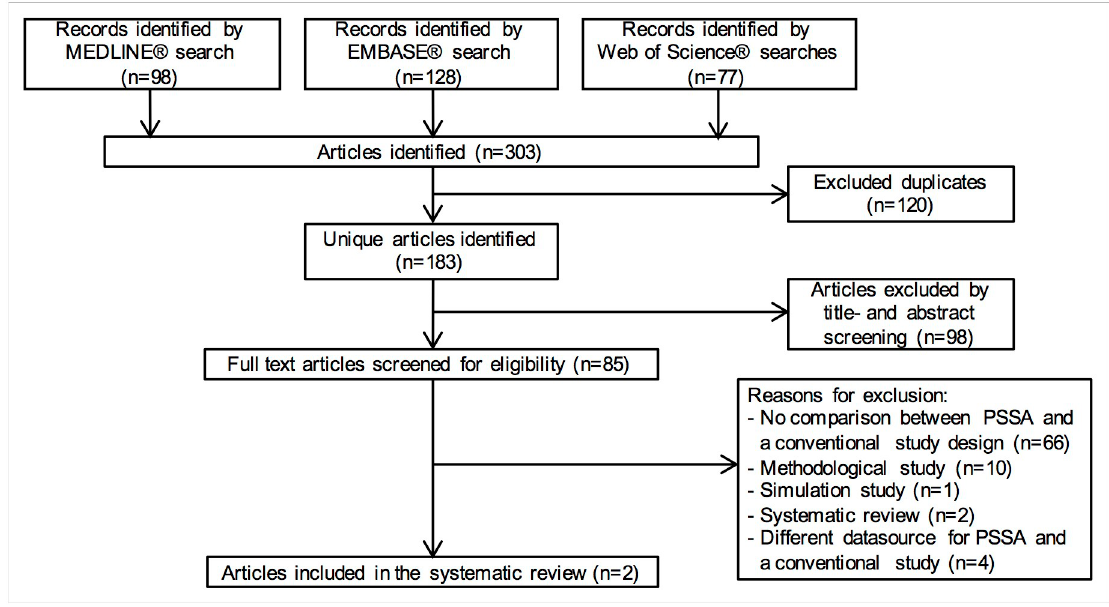
Fig 2. PRISMA flow diagram of the study selection process.